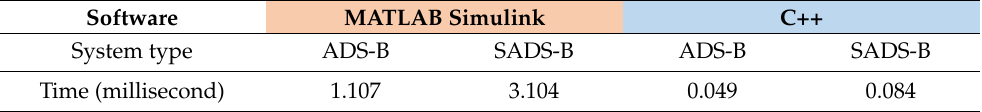
Figure 10. ( a ) Sensitivity test bench block diagram, ( b ) Measured accuracy of standard ADS-B and SADS-B signals.